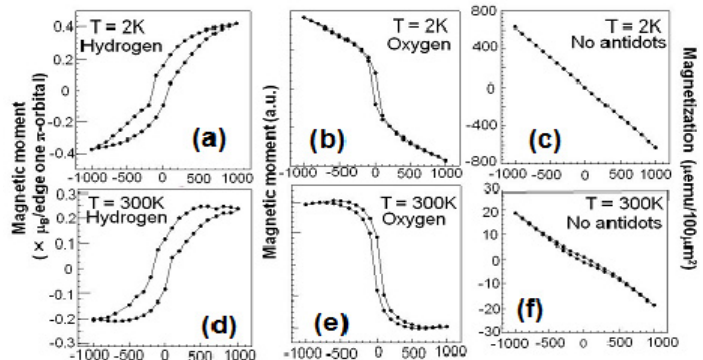
Figure 2. Magnetization of monolayer GNMs with ϕ ~ 80 nm and W ~ 20 nm for termination of different atoms. ( a , d ) hydrogen-terminated pore edges; ( b,e ) oxygen-terminated pore edges; and ( c , f ) bulk graphene without pore arrays. DC magnetization was measured by a superconducting quantum interference device (SQUID; Quantum Design). Magnetic fields were applied perpendicular to GNMs. The vertical axis in panels ( a ) and ( d ) denote magnetic moment per localized-edge π orbital, assuming mono-hydrogenation of individual edge carbon atoms as explained in